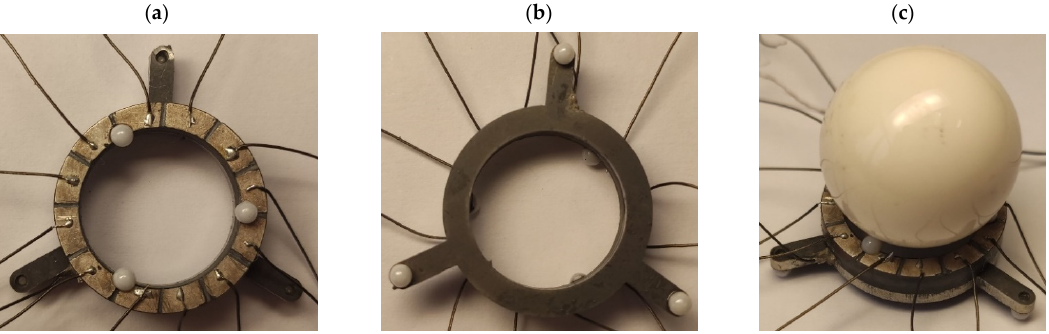
Figure 13. Prototype of the robot; ( a )—top view; ( b )—bottom view; ( c )—side view with spherical payload.